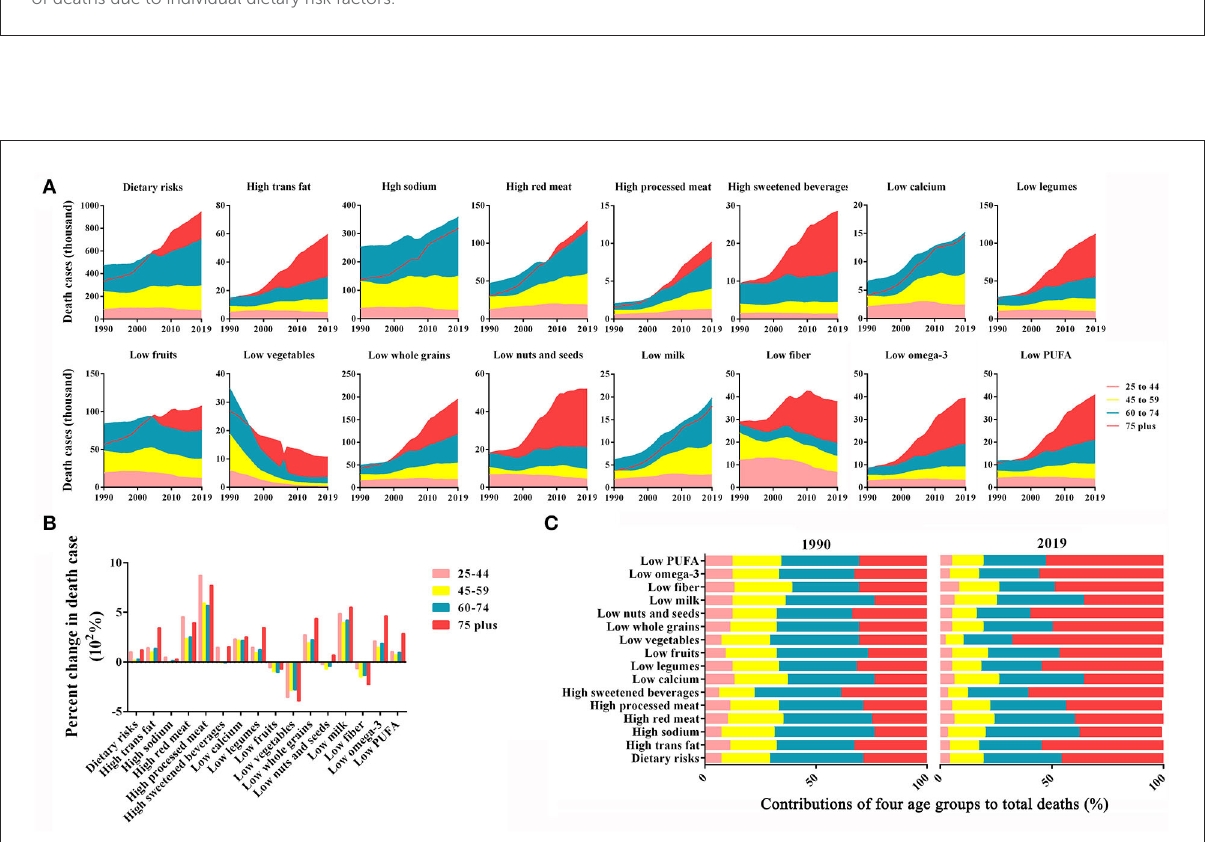
FIGURE2 Impact of individual factors of dietary risk on death burden in China from 1990 to 2019. (A,B) Deaths and ASDRs in individual factors of dietary risk by sex. (C) Percent changes in ASDRs in men and women. (D) Male-to-female ratios of ASDRs in individual factors of dietary risk. (E) Ranking of deaths due to individual dietary risk factors.